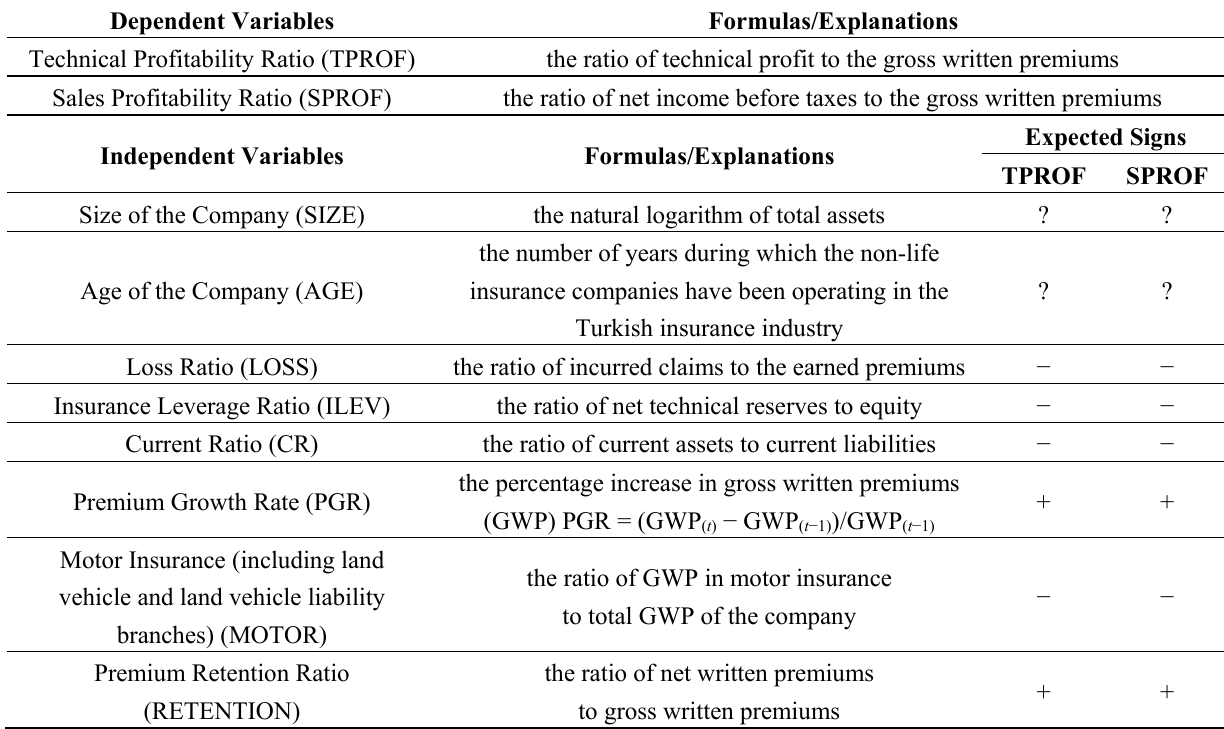
Table 3. Definitions of Variables and Expected